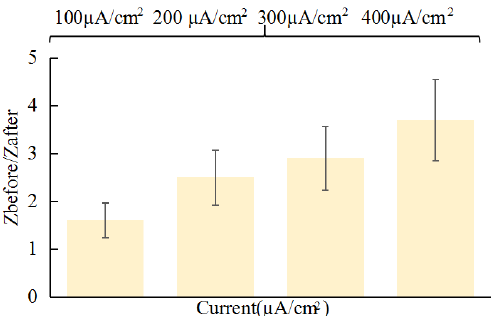
Figure 9. Effect of reverse iontophoresis (symmetricalbiphasic dc; different current density; reversed every 3 min during the 12 min) on the ratio of pre-experimental to post-experimental skin impedance ( Z before / Z after ).